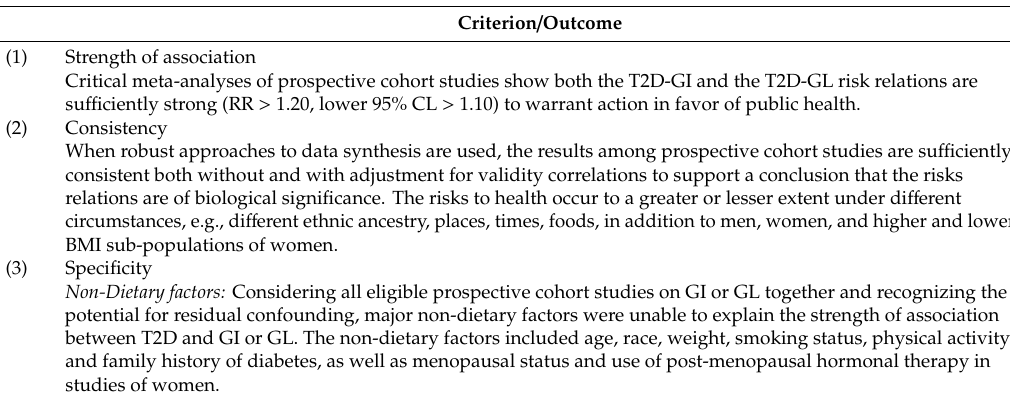
Table 2. Summary of the outcomes of this review according to the Bradford-Hill criteria (Points 1–9) and potential cost benefit (Point 10) a